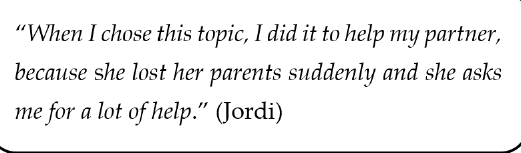
Figure 2. Co-researcher’s opinion 5.